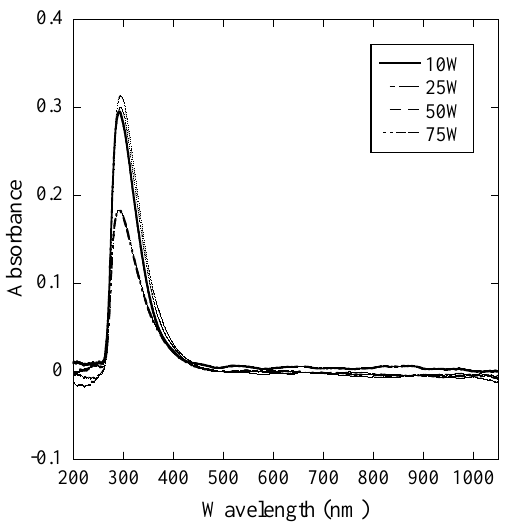
Figure 3. UV-Vis absorption spectrum of pp–GT thin